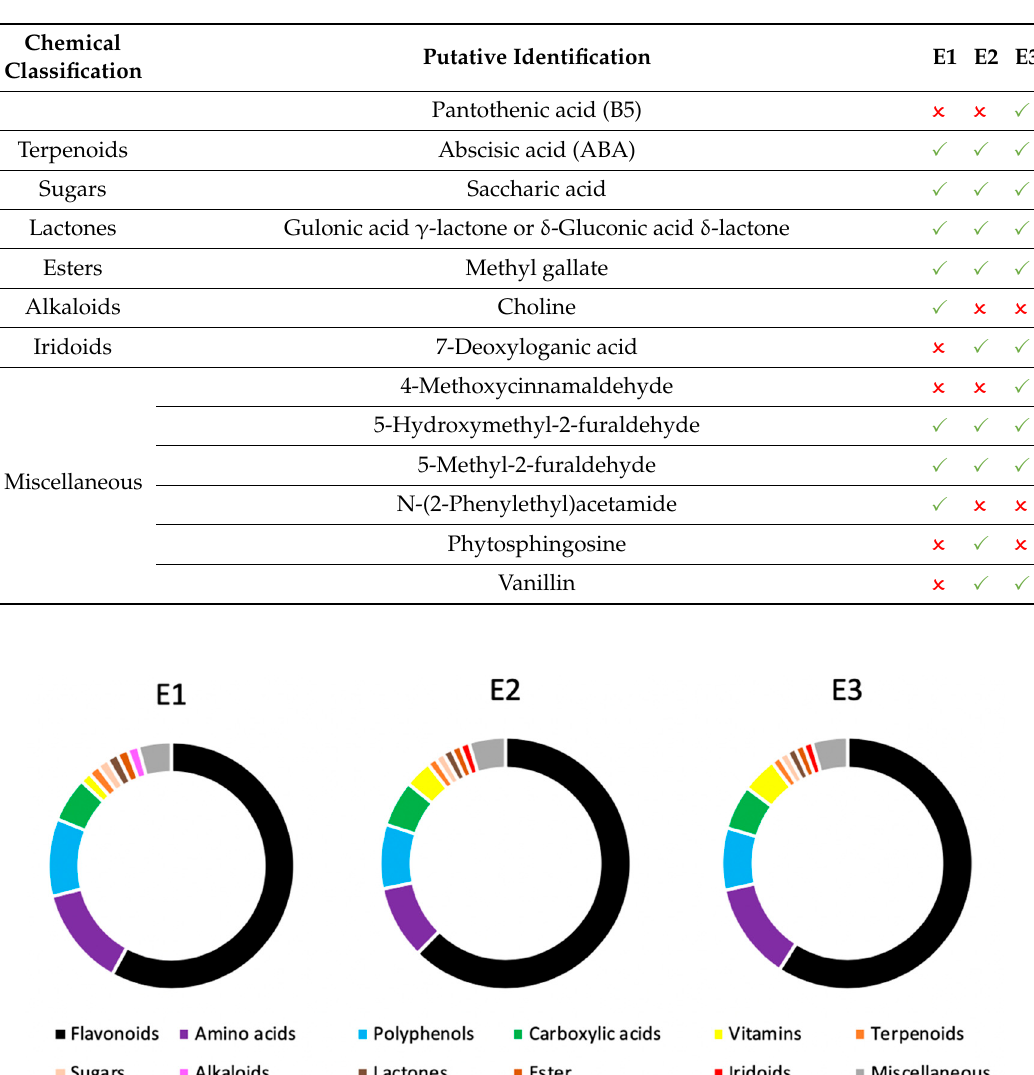
Figure 2. Composition based on the number of representatives of each class of compounds in the bilberry ripe fruit aqueous ( E1 ), methanolic ( E2 ), and hydro-methanolic ( E3 ) extracts.